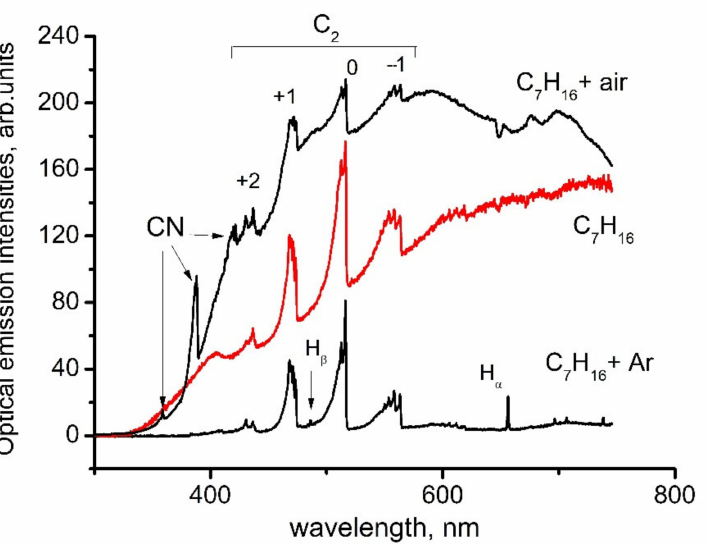
Figure 13. Examples of optical emission spectra of microwave discharge in liquid pure n -heptane and with bubbling of Ar and air. Spectra are given in arbitrary units for clear illustration the role of bubbling